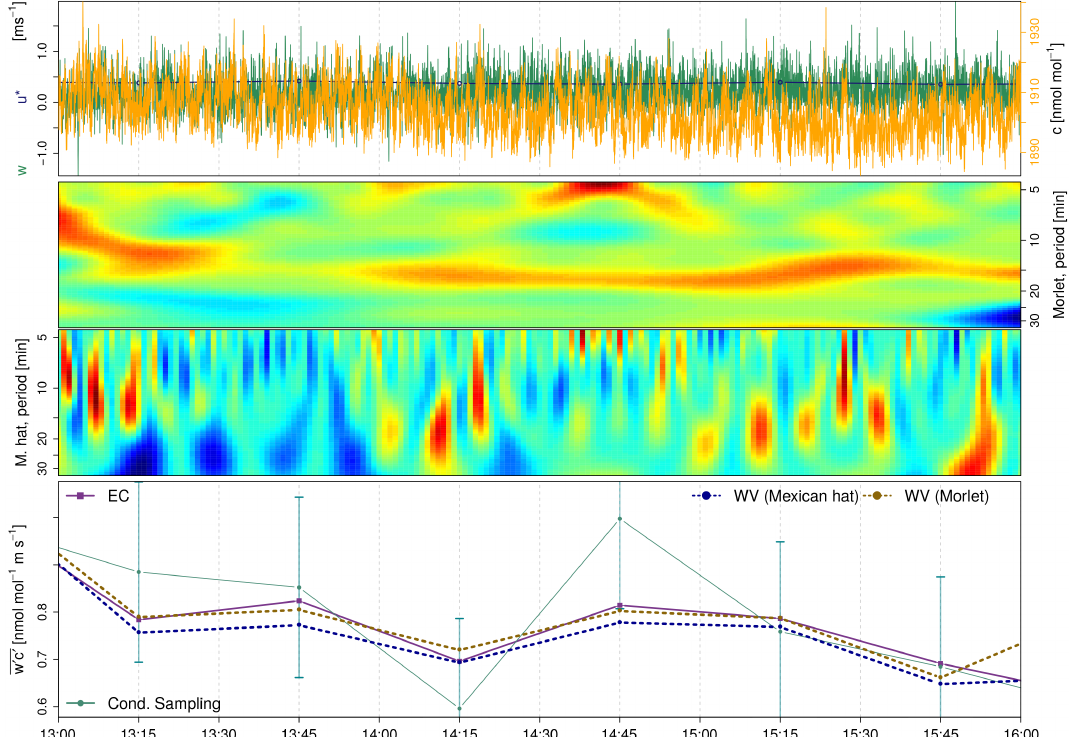
Figure 4. Case study of 23 July 2014. The colours in the wavelet cross-scalograms between w and c denote the flux intensity: blue refers to the smallest, green to medium and red to highest methane flux contributions. The cone of influence is outside of the scalogram, i.e. it was not affected by border effects. The third panel shows the 30min fluxes determined using the classical eddy covariance method (EC) and the conditional sampling method as well as the 1min fluxes of the wavelet method averaged on the same 30min interval as the other fluxes. The error bars for conditional sampling display the range of the result for w ± 10 − 4 ms − 1